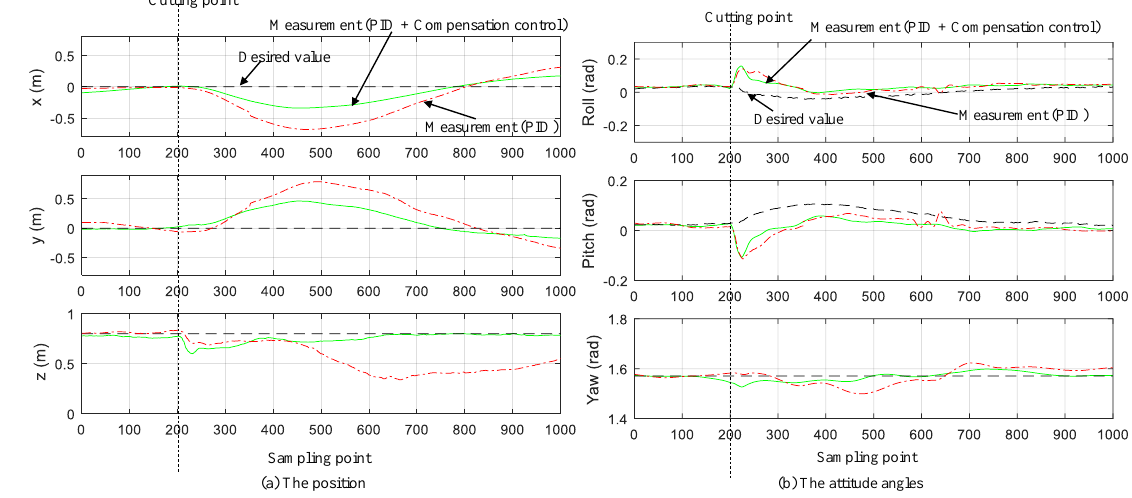
Figure 5. The experimental results. ( a ) The position; ( b ) The attitude angles.